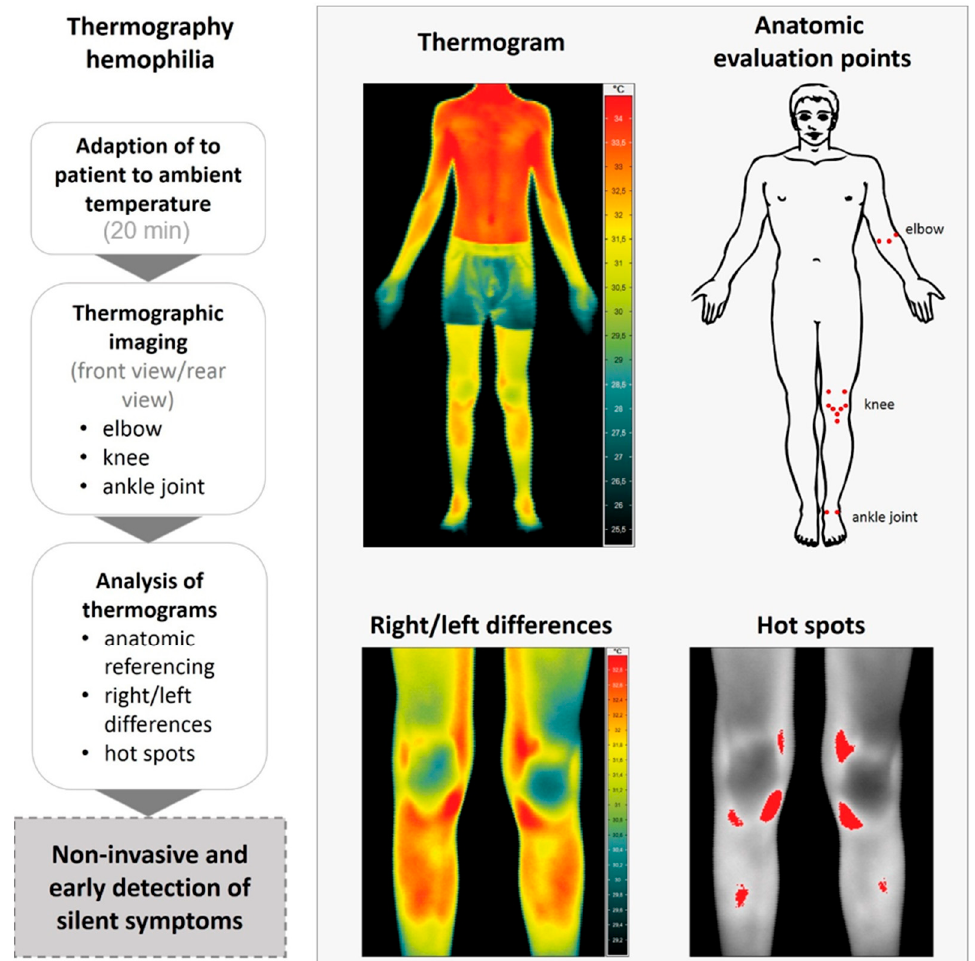
Figure 1. Workflow of thermographic image assessment and analysis of children with hemophilia ( left ) and example images for a termographic overview and close up images ( right ). After adaption period of 20 min to ambient temperature, thermograms of the individual anatomic points were assessed in front and rear view ( right ). According to anatomic reference points, right/left differences were calculated and correlated to clinical examination. Afterwards a confusion matrix was used to assess the accuracy, specificity and sensitivity of thermography compared to clinical examination.